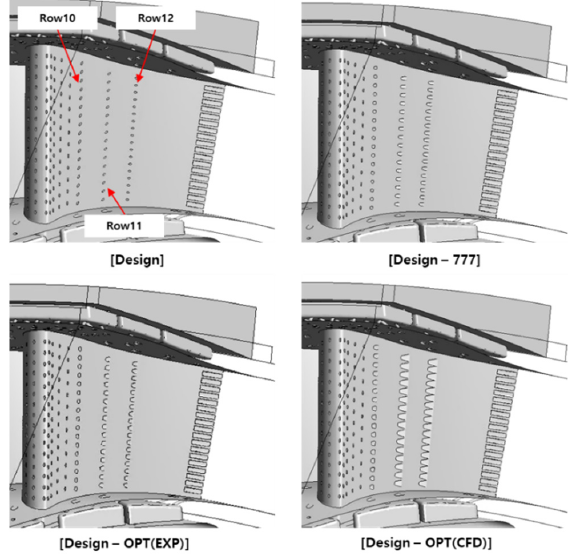
Figure 13. Cooling flow rate for the design (comparison between the actual and predicted values).